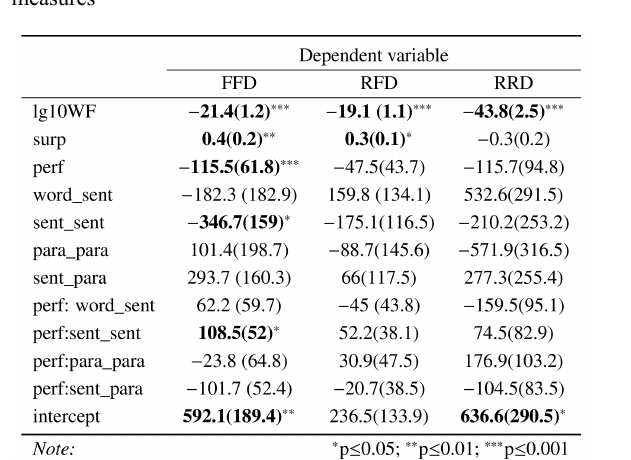
Table 3. Linear mixed model estimates for the three dependent measures